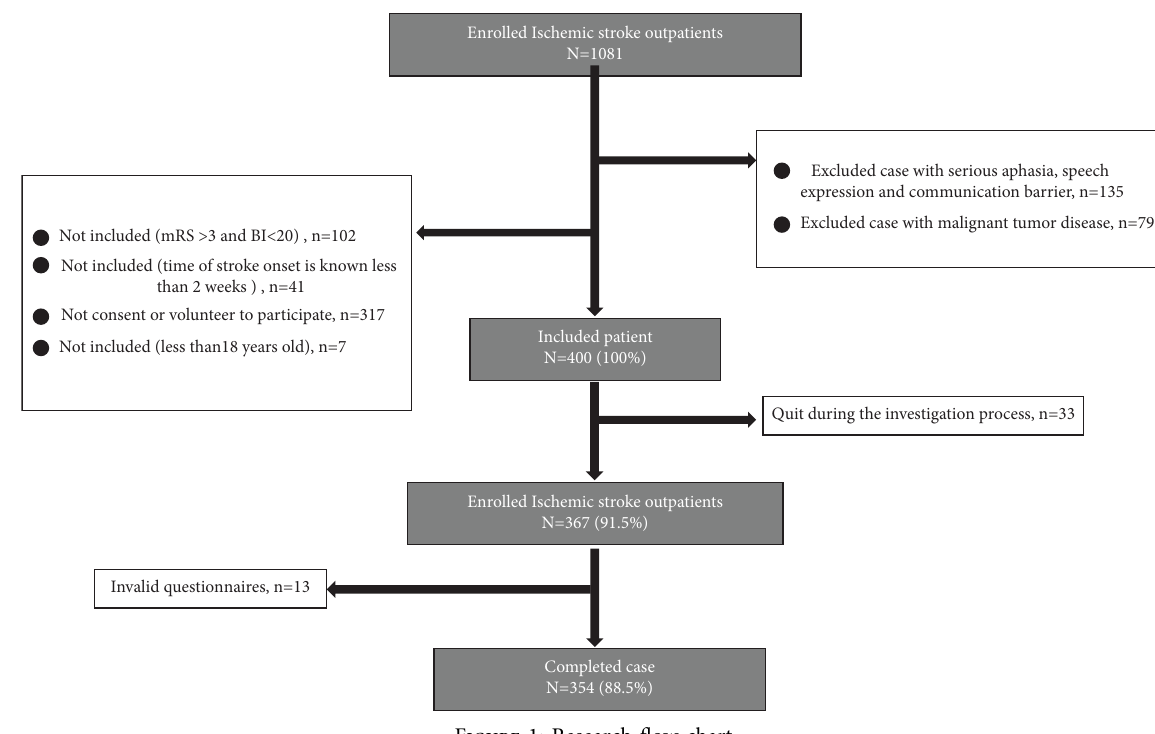
Figure 1: Research fow chart. Table 1: Demographic characteristics of the 354 efective